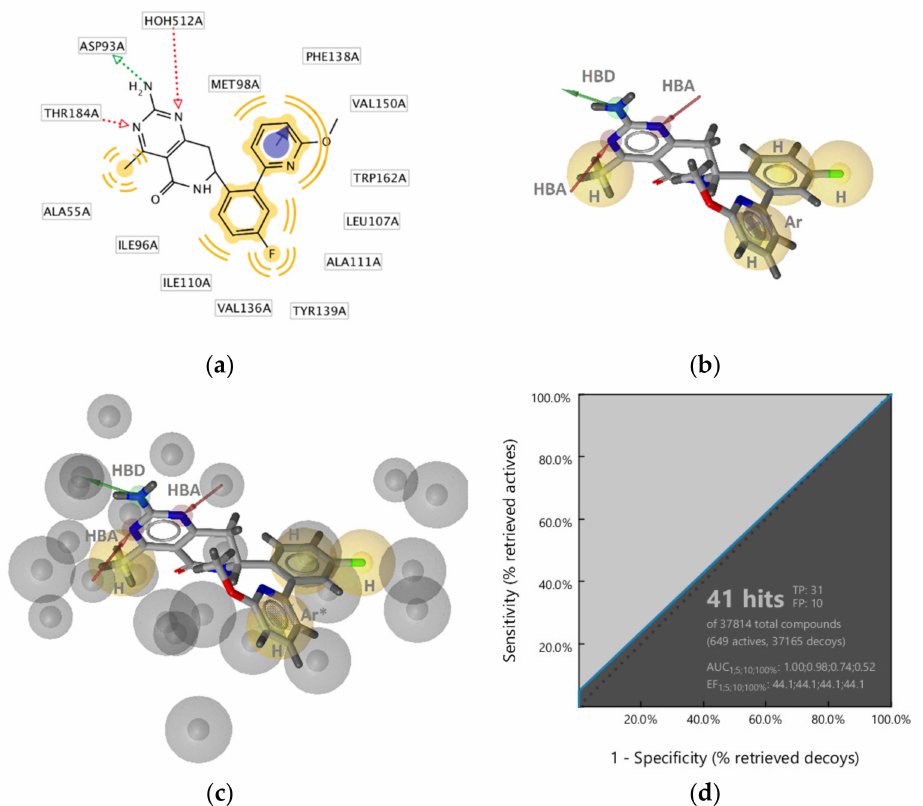
Figure 9. 3D-structure-based interactions derived from a dihydropyridopyrimidinone Hsp90 in- hibitor (PDB ID: 4U93): ( a ) 2D-depiction with binding site interaction partners and ( b ) 3D-depiction the SB-pharmacophore model with the ligand; ( c ) The refined SB-Hsp90-Model-2, ( d ) Receiving operating characteristic (ROC) (curve shown in blue) from virtually screening 37,814 compounds (649 Hsp90 actives and 37,165 generated decoys) with the refined SB-Hsp90-Model-2. TP = true positives; FP = false positives; AUC = area under the curve; EF = enrichment factor. Displayed pharmacophore features are: hydrophobic (H, yellow spheres), aromatic ring (Ar, blue disc), hy- drogen bond donor (HBD, green arrow), and hydrogen bond acceptor (HBA, red arrow). Optional pharmacophore features are marked with